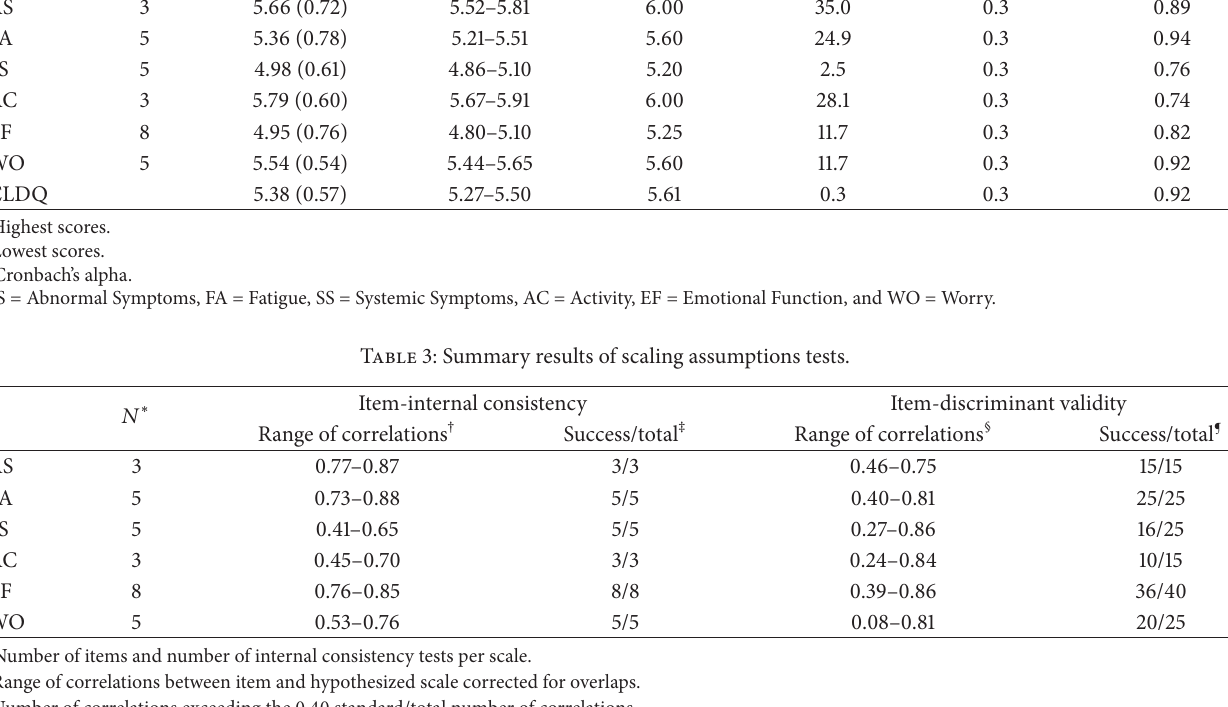
∗ Number of items and number of internal consistency tests per scale. †